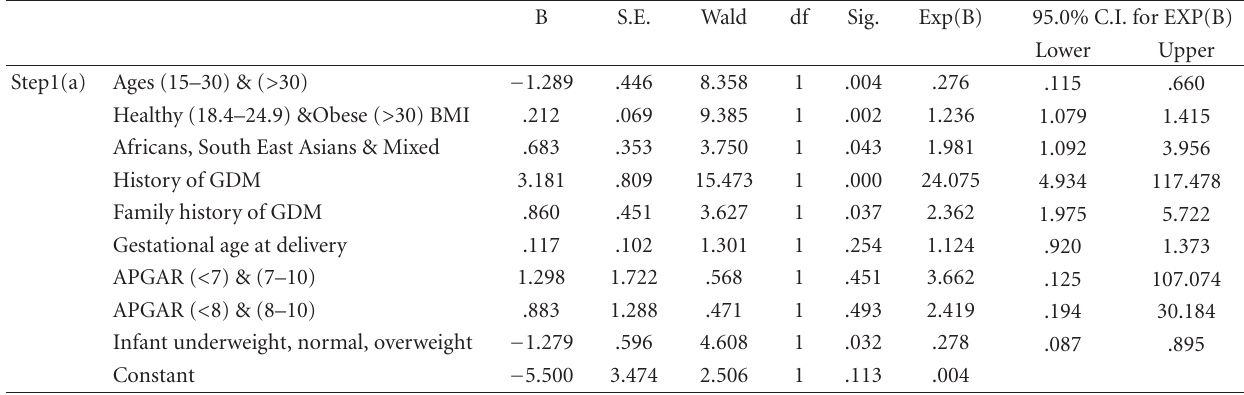
Table 3: Binary logistic